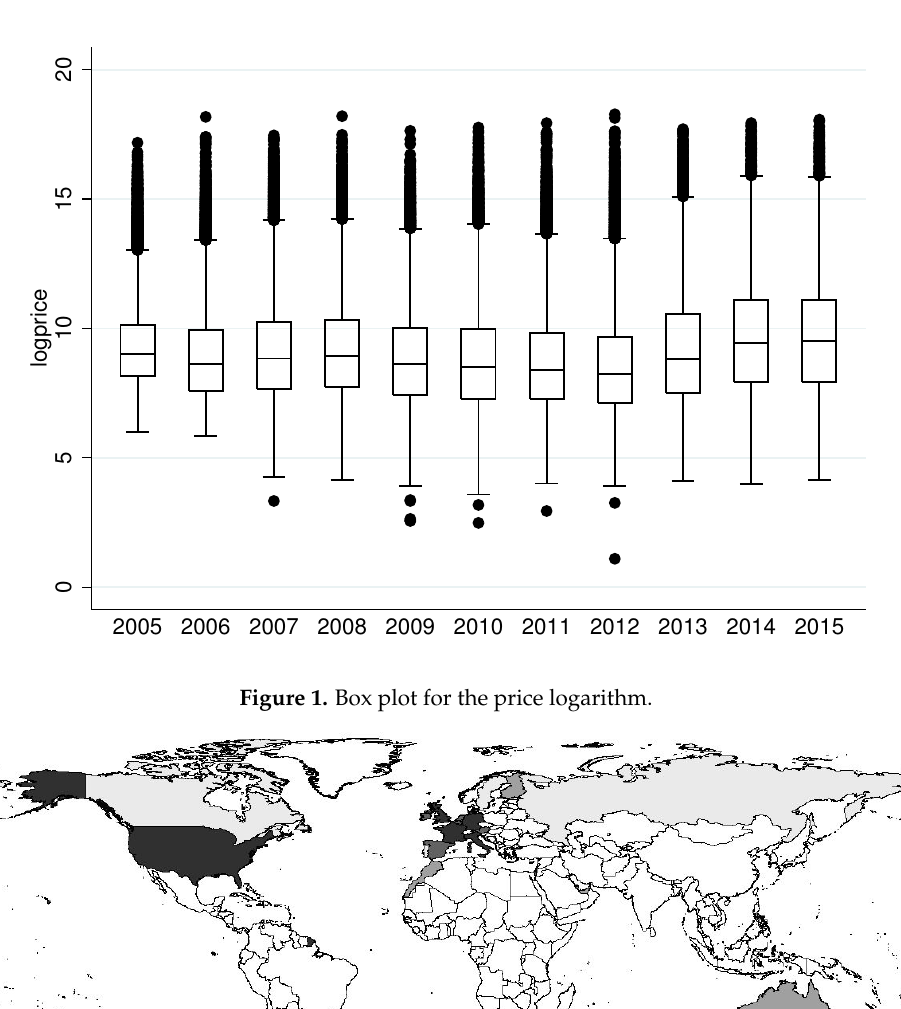
Figure 2. Map of auction’s revenue distribution among